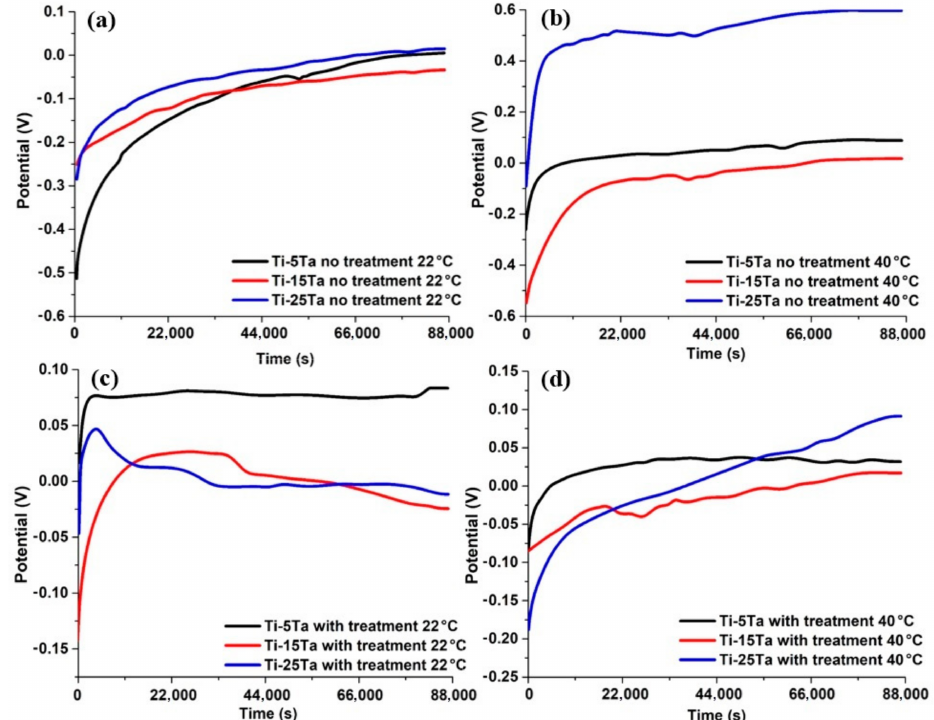
Figure 9. Open circuit potential curves for Ti-xTa alloys during 24 h immersion in the electrolyte in various conditions: ( a ) OCP results for samples without NaOH treatment at 22 ◦ C; ( b ) OCP results for samples without NaOH treatment at 40 ◦ C; ( c ) OCP results for samples with NaOH treatment at 22 ◦ C; and ( d ) OCP results for samples with NaOH treatment at 40 ◦